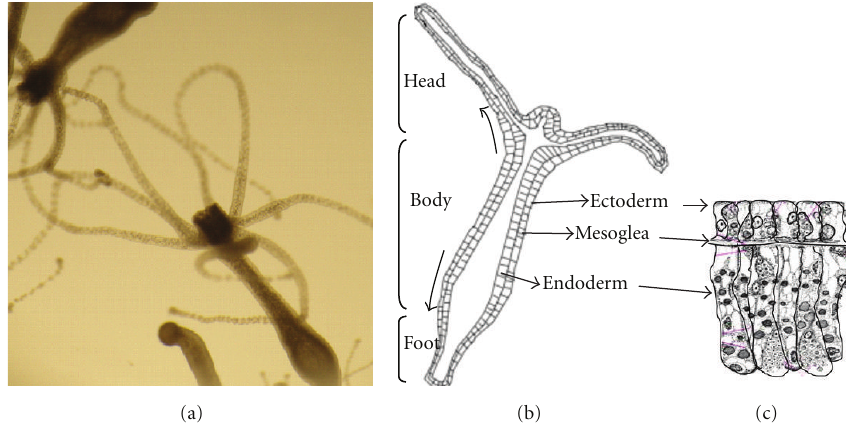
Figure 1: (a) Picture of living Hydra . The animal has a simple body plan: it is a tube with a head at the apical end and a foot or basal disc at the other. The head is in two parts, the hypostome (mouth) at the apex and below that the tentacle zone from which a ring of tentacles emerge. Scale bar 200 μ m. (b) Schematic representation of the bilayered structure of the animal: the body wall is composed of two self- renewing cell layers, an outer, the ectoderm, and an inner, the endoderm, separated by an extracellular matrix, the mesoglea. The arrows on the left side indicate the direction of tissue displacement. (c) Along the animal body, both ectoderm and endoderm layers are composed of epitheliomuscular cells, while interstitial stem cells and their intermediate and terminal derivatives (neurons, nematocytes, and secretory cells) are interspersed among ectoderm and endoderm.